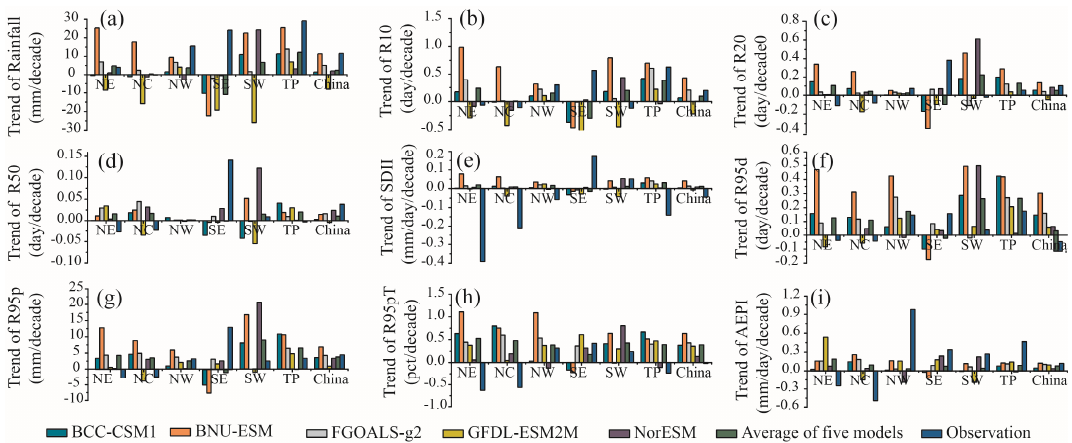
Water 2018 , 10 , x FOR PEER REVIEW 13 of 17 Figure A2. Averages of EPIs in China calculated from five CMIP5 models, average of the five models and the observations from 1960 to 2005: ( a ) annual average rainfall, ( b ) annual average R10, ( c ) annual average R20, ( d ) annual average R50, ( e ) annual average SDII, ( f ) annual average R95d, ( g ) annual average R95p, ( h ) annual average R95pT, and ( i ) annual average in AEPI.